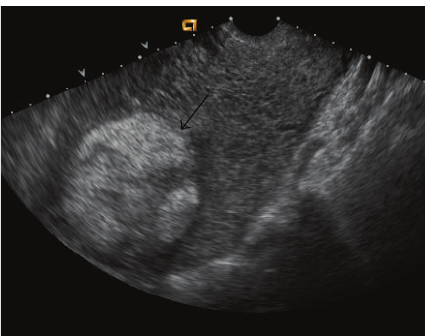
Figure 1: Gray-scale US demonstrates an echogenic mass in the endometrial cavity (black arrow).